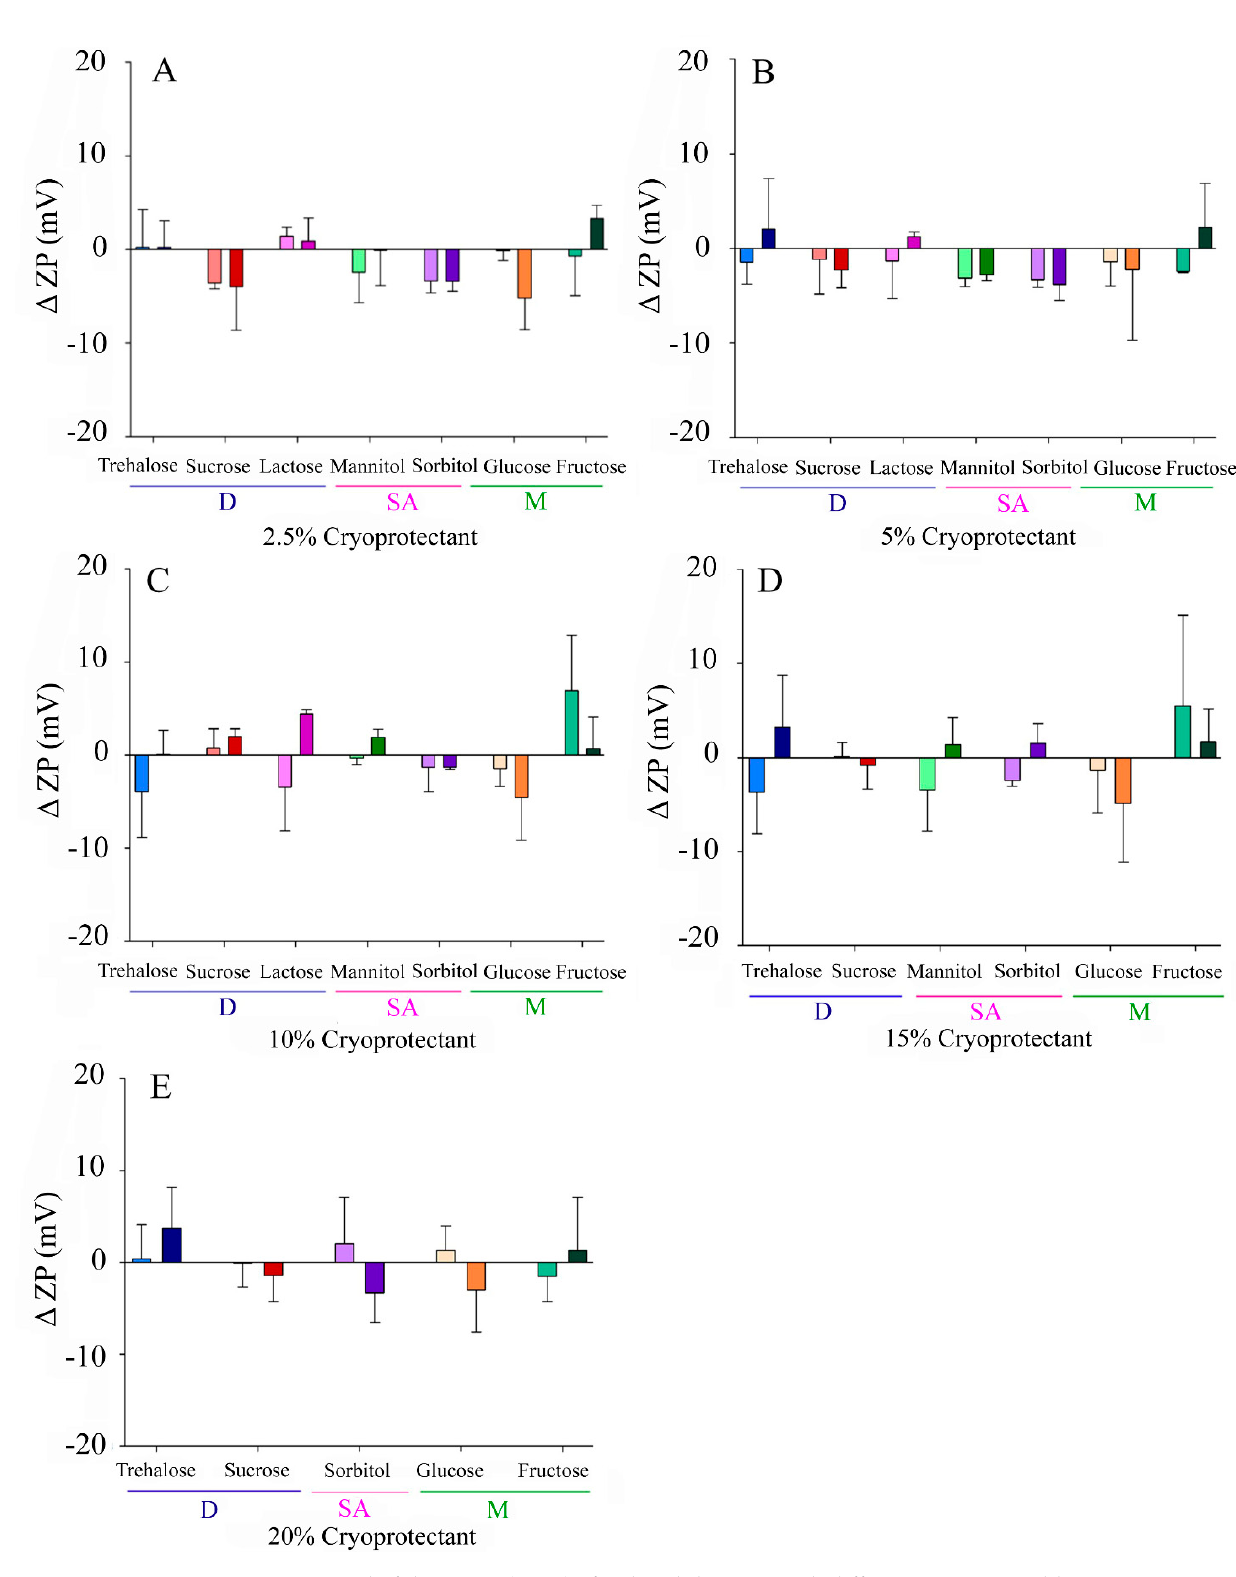
Figure 4. Increase in zeta potential of the NLCs ( Δ ZP) after lyophilization with different CPs at variable concentrations: ( A ) 2.5% w/v , ( B ) 5% w/v , ( C ) 10% w/v , ( D ), 15% ( w/v ), ( E ) 20% w/v . Light colours correspond to slow freezing processes and dark colours to fast freezing processes. The CPs are grouped according to their type into disaccharides (D), sugar alcohols (SA), and monosaccharides (M).